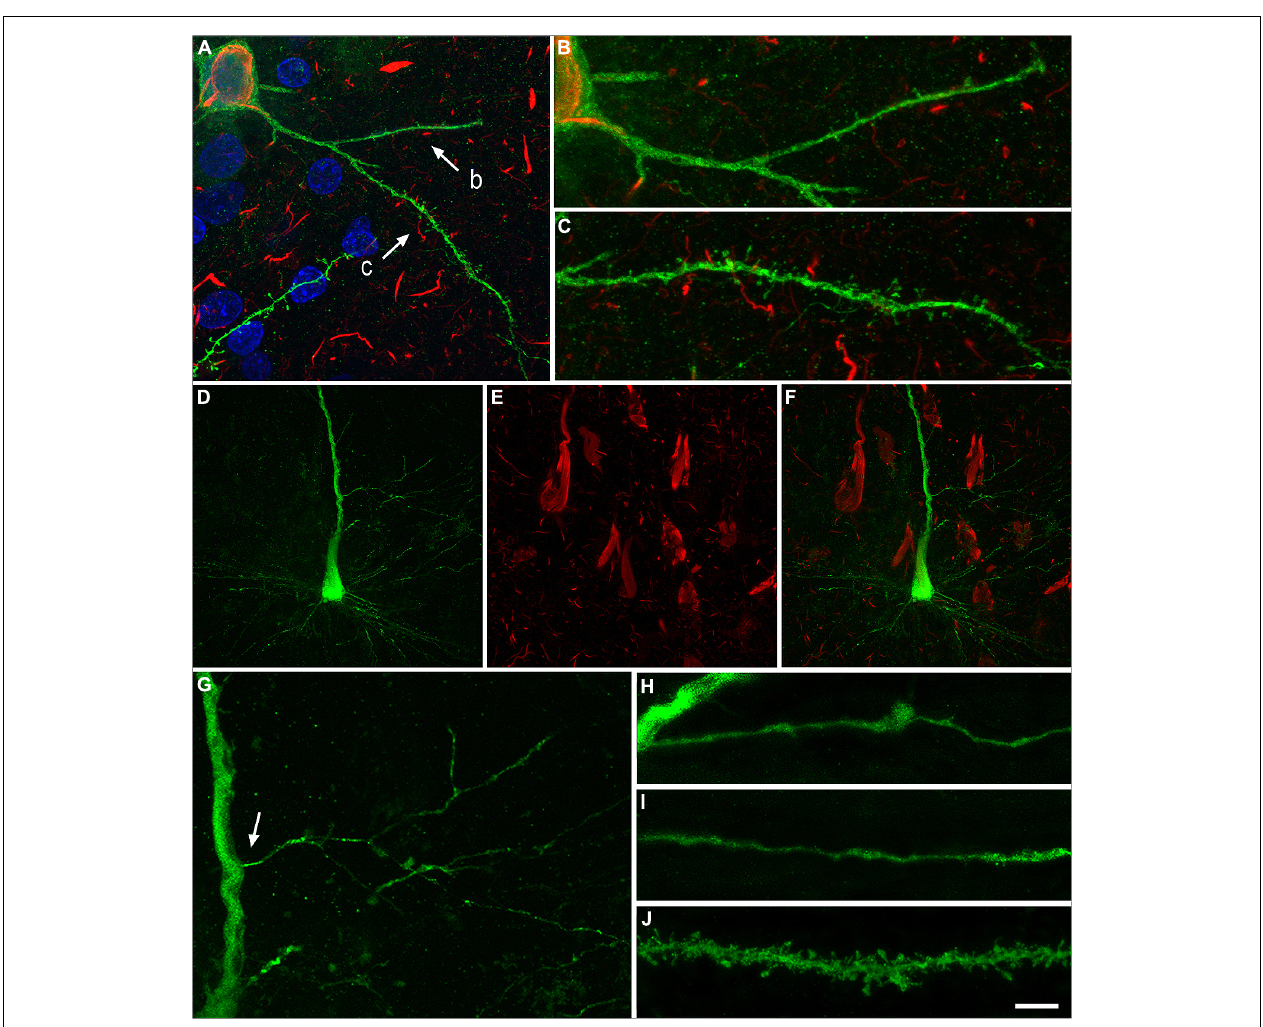
sections showing the cell body and proximal dendrites of the intracellular labeled neuron (D) with pattern IIb PHF-tau PHF − 1 -ir (E) . (F) , image obtained by combining (D , E) . (G) Higher magnification of (D) . (H,I), Stacks of 38 − 55 confocal optical sections from a collateral apical dendrite (arrow in G) of the LY-injected pyramidal neuron, showing different segments of the same dendrite (H , proximal; I , distant). (J) , Stack of 26 confocal optical sections from the collateral apical dendrite of an intracellularly labeled neuron that was adjacent to the LY-injected neuron shown in (D) , and that was not PHF-tau PHF − 1 -ir. Note the lack of dendritic spines and the thin diameter of the dendrites of the PHF-tau PHF − 1 -ir neuron (H,I) compared to the dendrite of the PHF-tau − neuron (J) . Scale bar in (J) : 10 μ m in (A) ; 3.5 μ m in (B,C) ; 20 μ m in (D − F) ; 9 μ m in (G) ; 4.5 in (H − J) .Taken from Merino-Serrais etal.